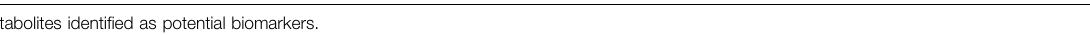
TABLE 3 | Metabolites identi fi ed as potential biomarkers.